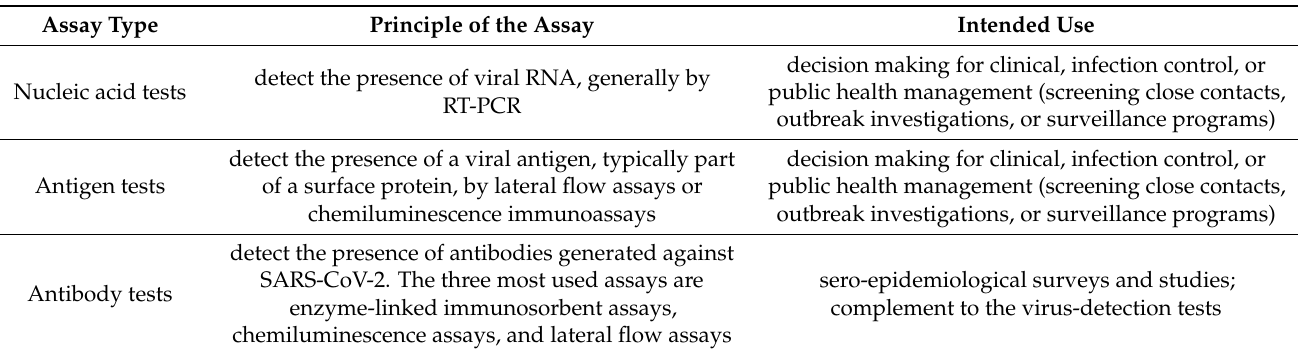
Table 1. Summary of the main features of existing tests for COVID-19 diagnosis. Assay